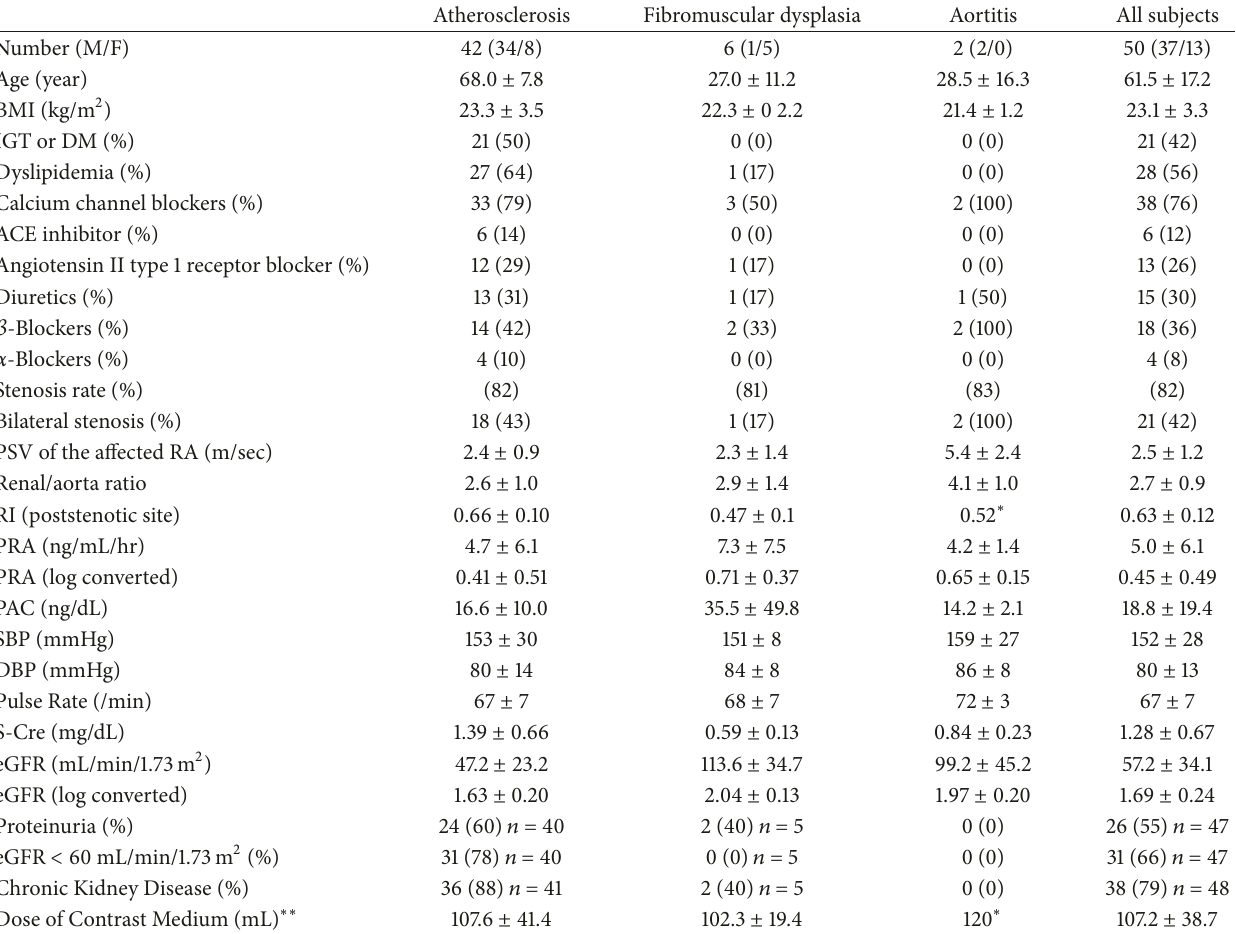
Table 1: Baseline characteristics. Data are described as “mean ± standard deviation,” or “number (percentage).” M: male; F: female; BMI: body mass index; IGT: impaired glucose tolerance; DM: diabetes mellitus; PSV: peak systolic velocity; RA: renal arteries; RI: resistive index; SBP: systolic blood pressure; DBP: diastolic BP; S-Cre: serum creatinine; eGFR: estimated glomerular filtration rate; proteinuria: